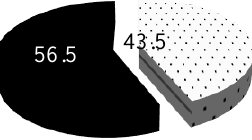
Figure 3. The preference of pupils to purchase the product if a favourite cartoon character is on the packaging of one of the products. Source: the authors'